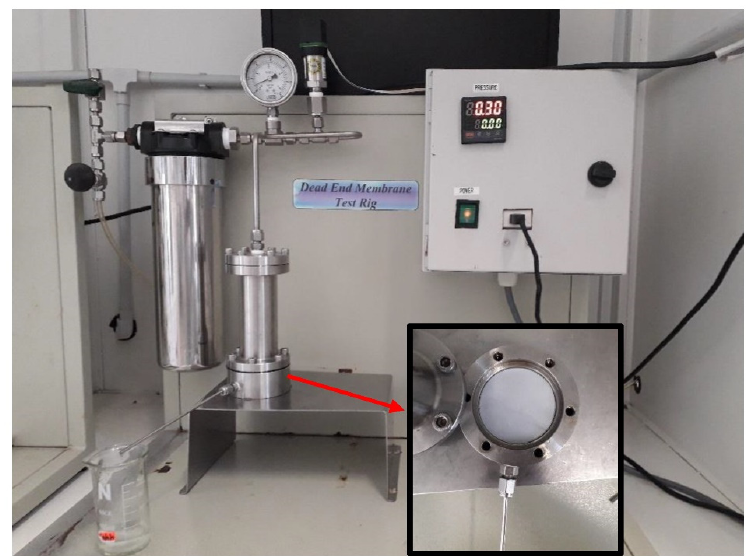
Figure 4. Dead-end test (pure water permeation set-up).